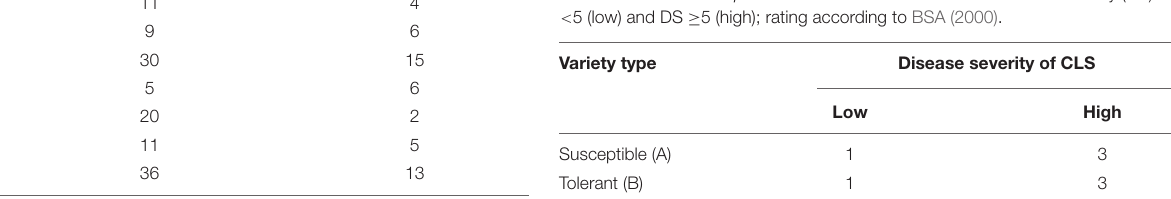
National variety trials in Germany, DS rating according to BSA (2000).